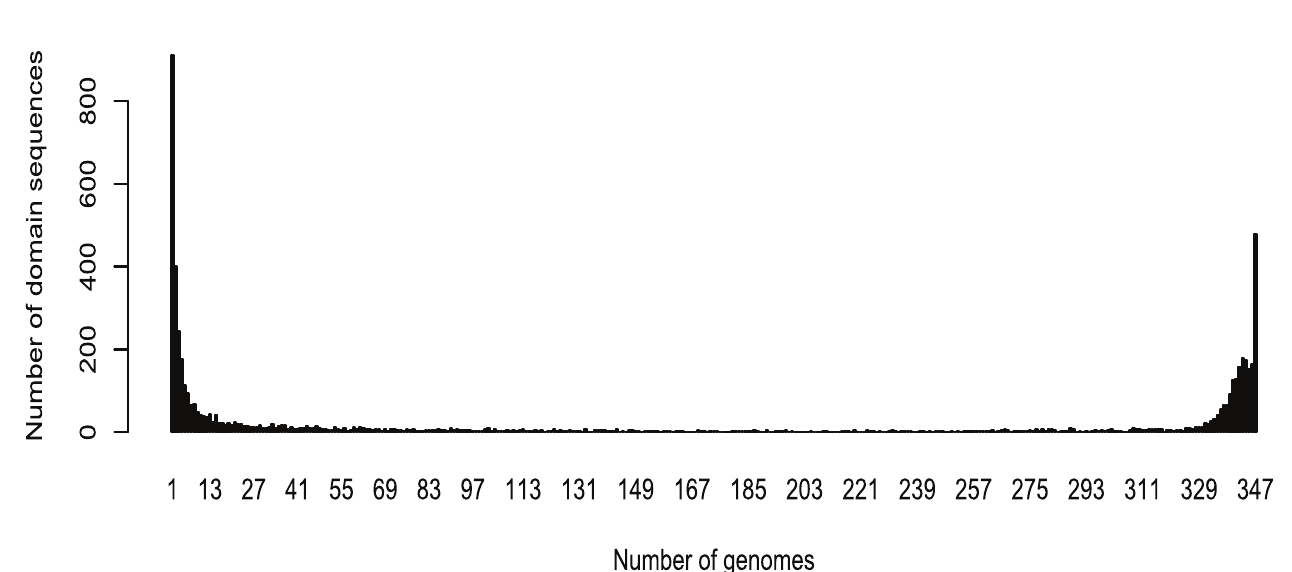
Figure 3. Gene family distribution. The distributions of how many domain sequence families are found in 1, 2,...,347 genomes. There are 909 ORFan families (leftmost bar), 479 core families (rightmost bar) and in total there are 5724 unique domain sequence families (sum of all bars).